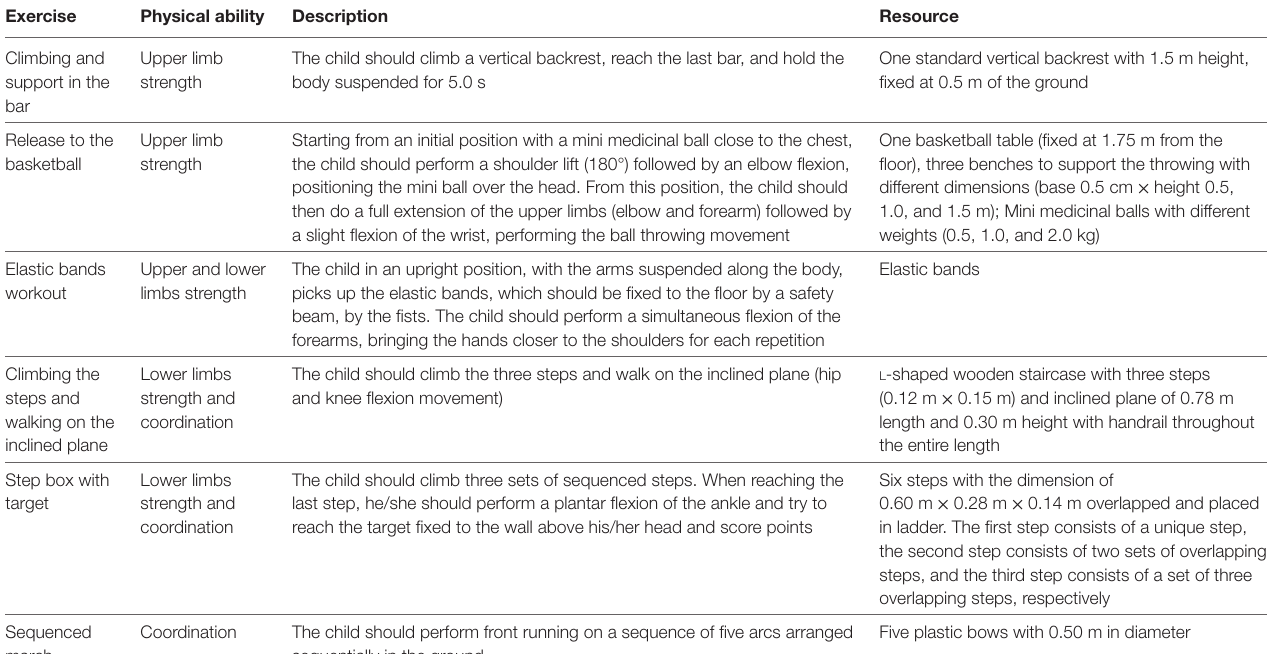
tABlE 1 | Overview of the PEP-Aut specific physical exercises used for intervention.